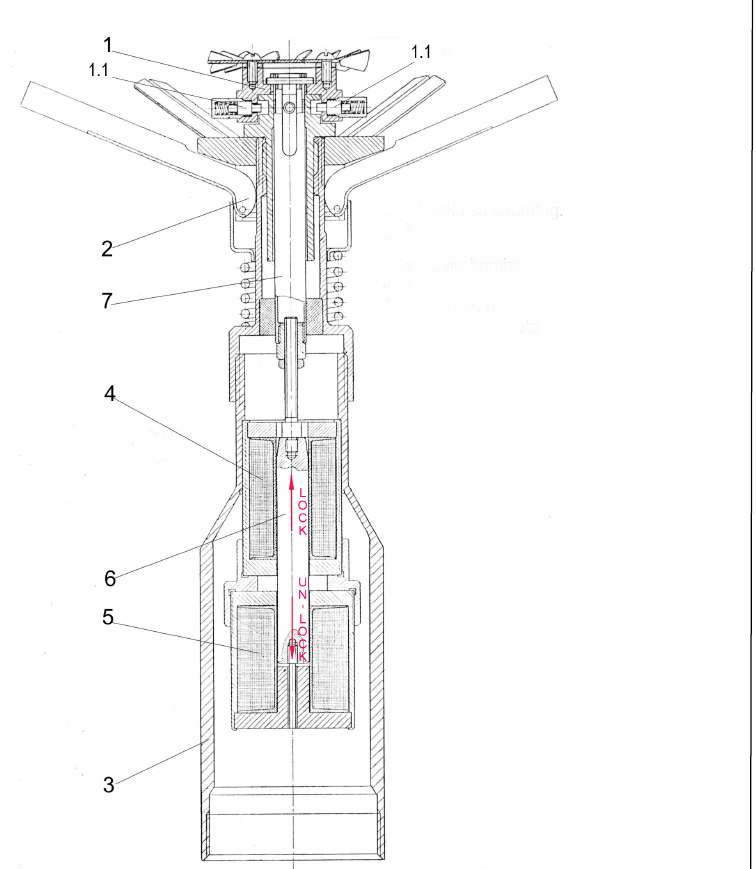
1.1 – centrifugalni osigura č i, 2 – stabilizator sa sklapaju ć im krilcima, 3 – telo bombe, 4 – elektromagnet I, 5 – elektromagnet II, 6 – kotva, 7 – viljuška Рис . 6 – Реконструированная модель ПТАБ ( поперечное сечение ): 1 – крыльчатка , 1.1 - центробежные предохранители , 2- стабилизатор со складывающимися лопастями , 3 – корпус бомбы , 4 – электромагнит I, электромагнит II, съемник , Figure 6 – Redesigned PTAB Test Model (cross-section): 1 – arming vane, 1.1 – centrifugal safety pins, 2 – stabilizer tail unit with folding fins, 3 – bomb body, 4 – electro-magnet I, 5 – electro-magnet II, 6 – lifter, 7 – locking fork 7 – вилка -